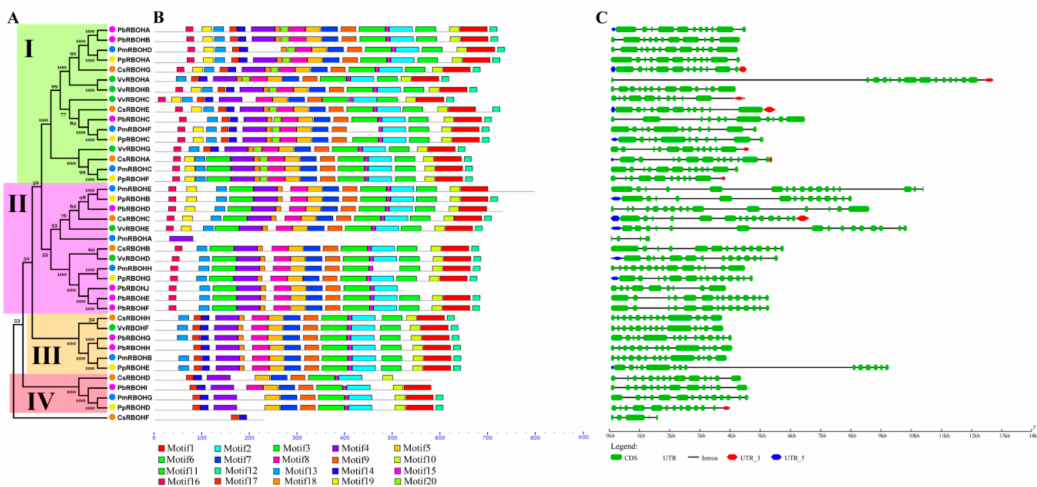
Figure 2. The gene structures and conserved motifs of RBOH family members of five fruit-producing trees based on the evolutionary relationship. ( A ) Phylogenetic tree of RBOH family members of five fruit-producing trees. ( B ) Conserved motifs of RBOHs of five fruit-producing trees. ( C ) The exon-intron structure of PbRBOH s of five fruit-producing